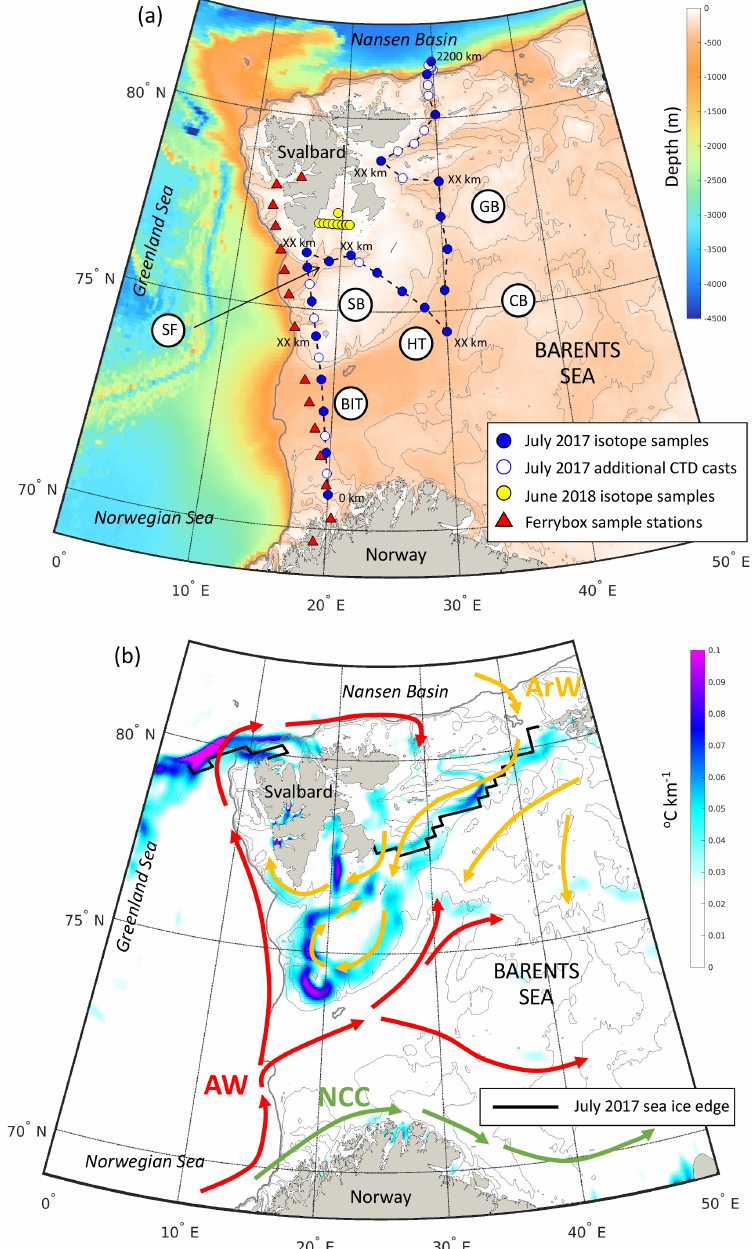
Figure 1. (a) Station locations within the Barents Sea from JR16006 during July 2017 and on repeat Ferrybox transects in March, June, August and November 2018. Shading is the depth (in metres). The grey contours mark the 200, 300 and 500m isobaths. Key bathymetric features are marked: Bear Island Trough (BIT), Hopen Trench (HT), Spitsbergen Bank (SB), Central Bank (CB), Great Bank (GB), Stor- fjordrenna (SR), Kong Karls Land (KKL) and the Barents Sea Opening (BSO). Distances along the transects presented in Figs. 2 and 3 are marked. (b) Schematic of the circulation of Atlantic Water (AW), Arctic Water (ArW) and the Norwegian Coastal Current (NCC). Shading is the July 2017 sea surface temperature gradient ( ◦ Ckm − 1 ) calculated from the OSTIA SST product (Donlon et al., 2012) and shows the sea surface temperature expression of the polar front along the edges of Spitsbergen Bank and Great Bank. The solid black contour marks the July 2017 sea ice edge (data from the National Snow and Ice Data Center). Grey bathymetric contours are like in (a) .